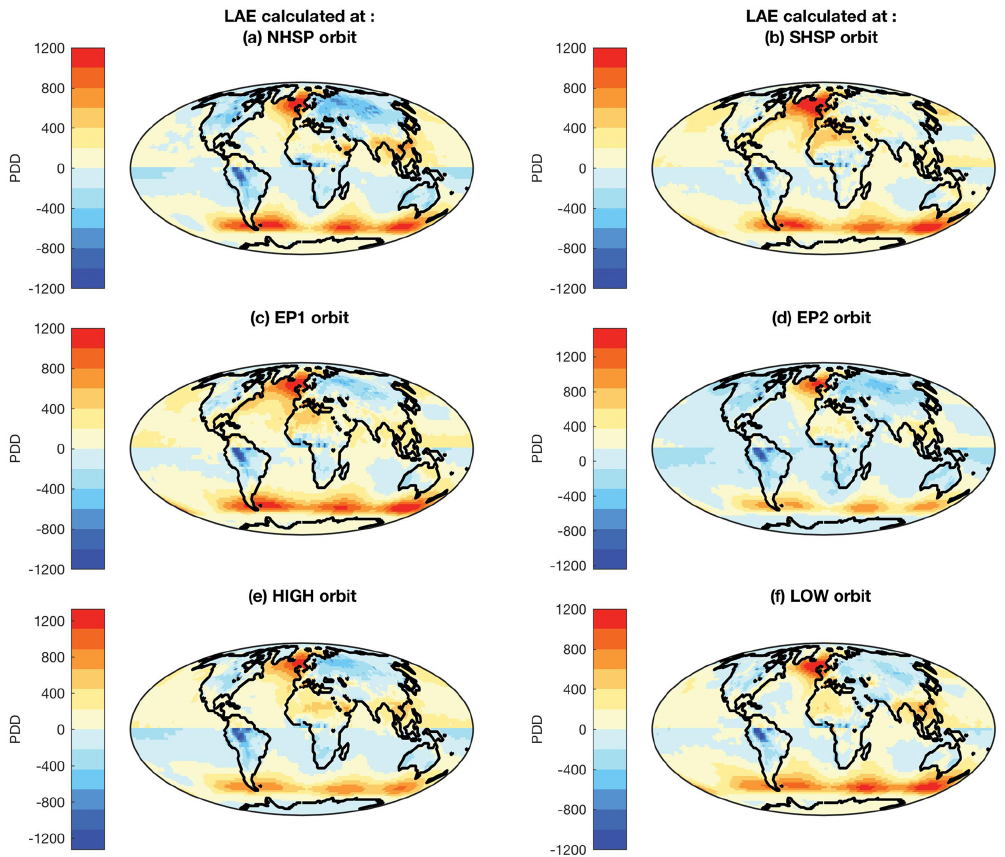
Figure 6. Interhemispheric effect of continental geography (LAE) on the climate response (PDD) at (a) NH summer at perihelion; (b) SH summer at perihelion; (c) NH vernal equinox at perihelion; (d) NH autumnal equinox at perihelion; (e) HIGH obliquity orbit; and (f) LOW obliquity